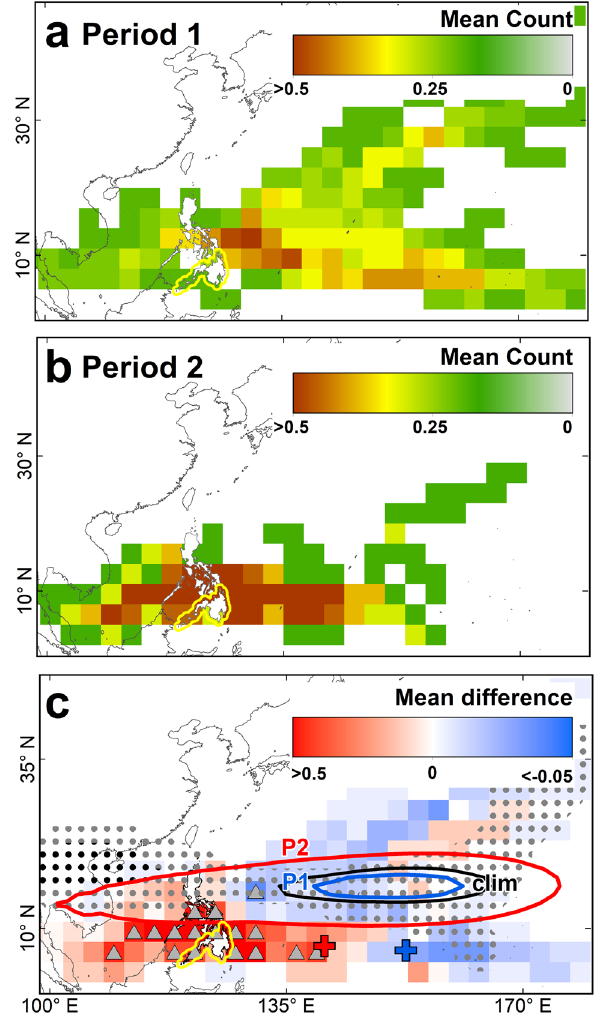
Figure 2. Christmas typhoon passages in the Western North Pacific. Mean TC passage frequency during Period 1 ( a ) and Period 2 ( b ). ( c ) Difference in mean TC passage frequency between Period 2 and Period 1. The gray triangles indicate significant difference in mean TC passage frequency at p < 0.05 level. The black (gray) dots represent the significant difference in geopotential height at p < 0.01 ( p < 0.05) level, respectively. The red (blue) cross denotes the mean TC genesis point during Period 2 (Period 1). The red and blue contours represent the location of the WNP subtropical high (= 5873 gpm) during the Period 2 (P2) and Period 1 (P1) while the black contour shows its climatological location (clim). The yellow line indicates the location of Mindanao Island. In ( a – c ), the maps are plotted using ArcGIS 10.1 (https:// www. esri.